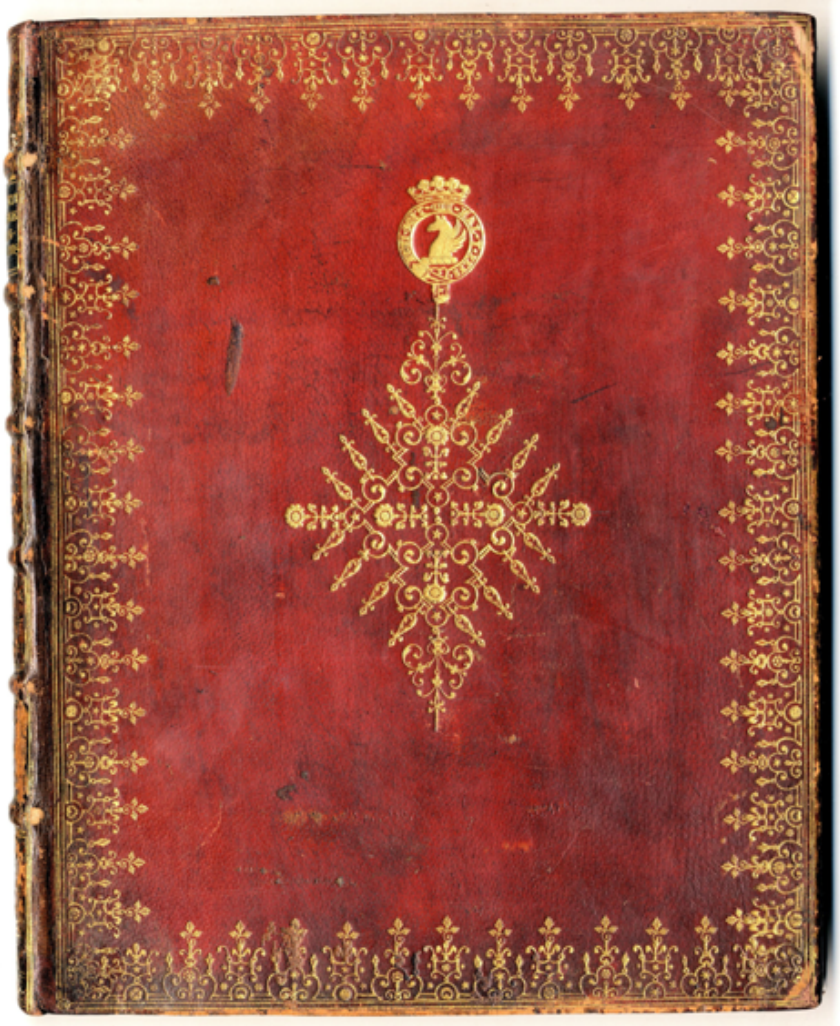
Fig. 14. ‘Harleian’ style binding with the crest of John Montagu, 2nd Duke of Montagu, and characteristic flower tool used six times on the upper cover. Copyright and reproduced by permission of the Museum of Freemasonry, London.